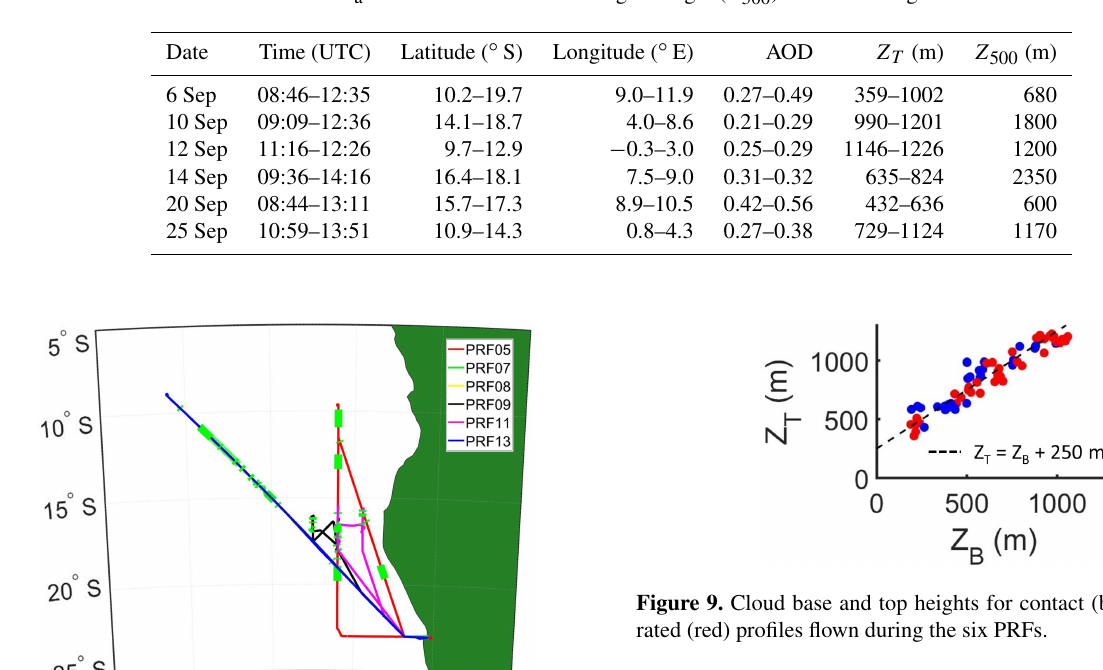
Table 4. The range of time, latitude, longitude, above-cloud AOD, and cloud-top height ( Z T ) for cloud profiles flown during the six flights. The lowest altitude where above-cloud N a > 500cm − 3 occurred during the flight ( Z 500 ) is in the far-right column.